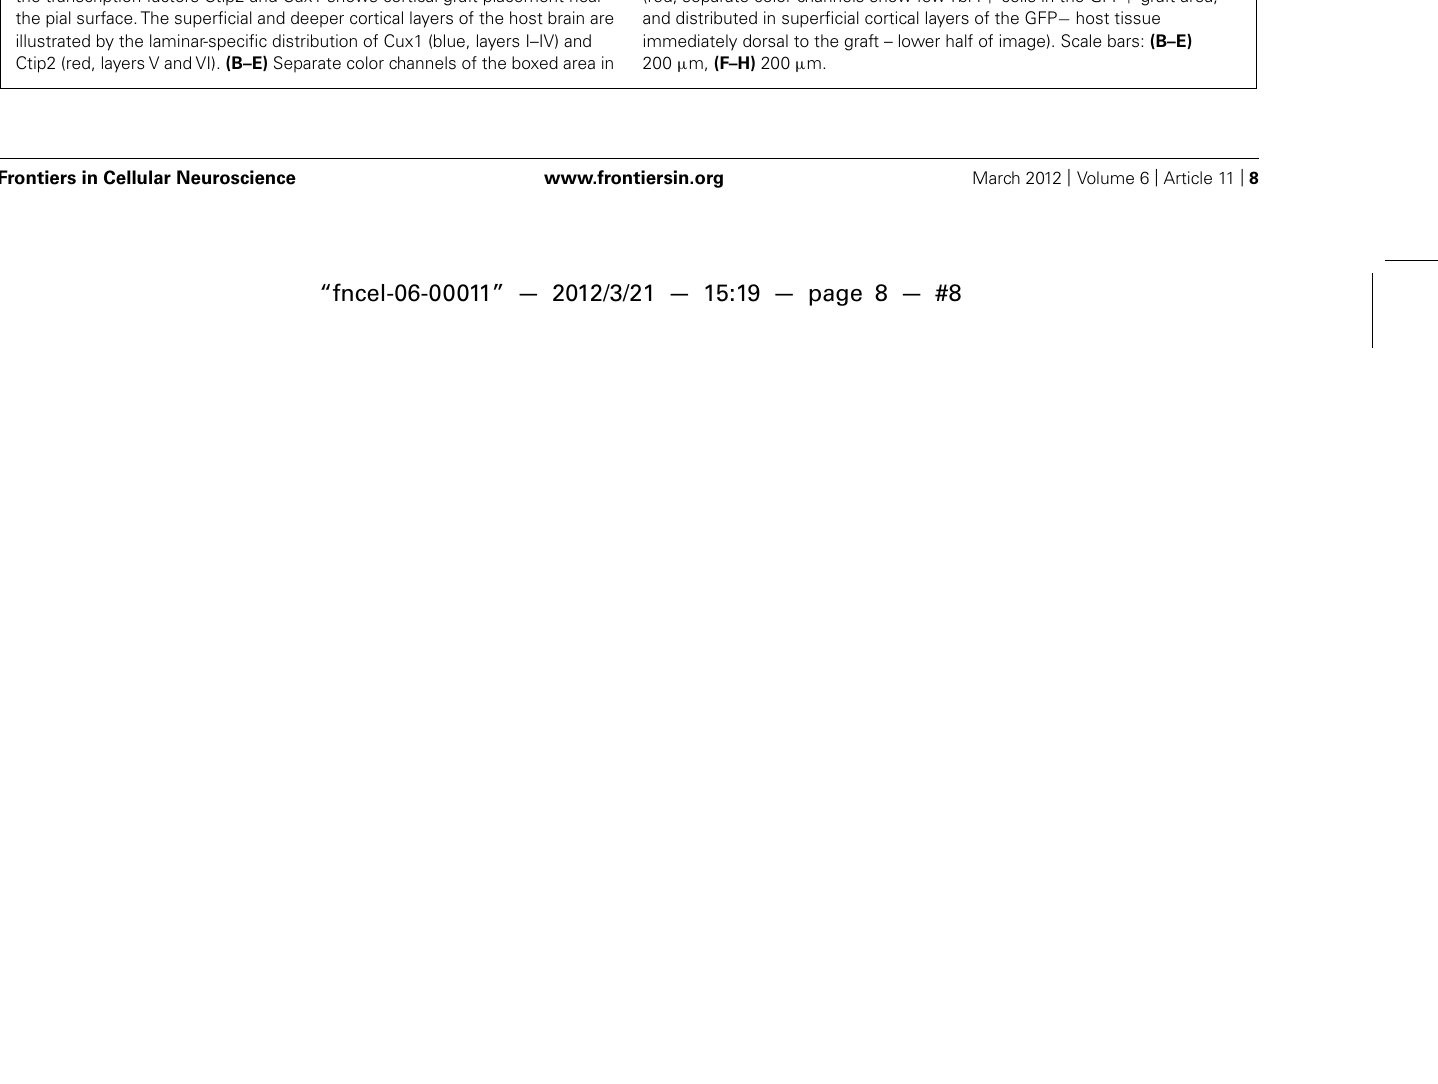
FIGURE 5 | Expression of transcription factors with layer-specific cortical expression patterns indicates some level of regional specification in a subset of the grafted cells. (A) Immunohistochemistry for GFP (green) and the transcription factors Ctip2 and Cux1 shows cortical graft placement near the pial surface.The superficial and deeper cortical layers of the host brain are illustrated by the laminar-specific distribution of Cux1 (blue, layers I–IV) and Ctip2 (red, layersV andVI). (B–E) Separate color channels of the boxed area in